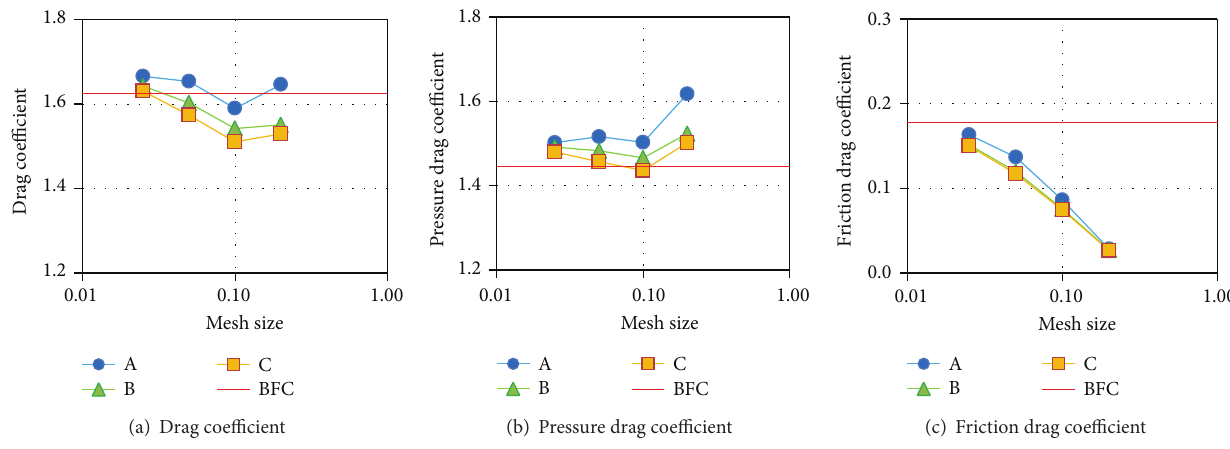
Figure 14: Effect of mesh size on aerodynamic coefficients at Mach 1.2. The red lines are reference